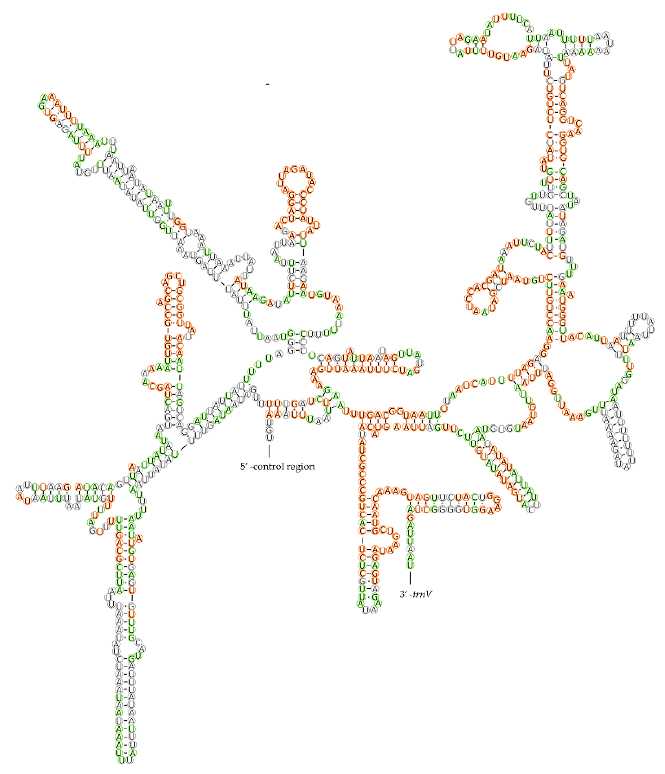
Figure 6. Potential secondary structure of 12S rRNA in Eysarcoris rosaceus . The sites conserved within Eysarcoris are labeled in green, and those of Pentatominae are marked in orange.